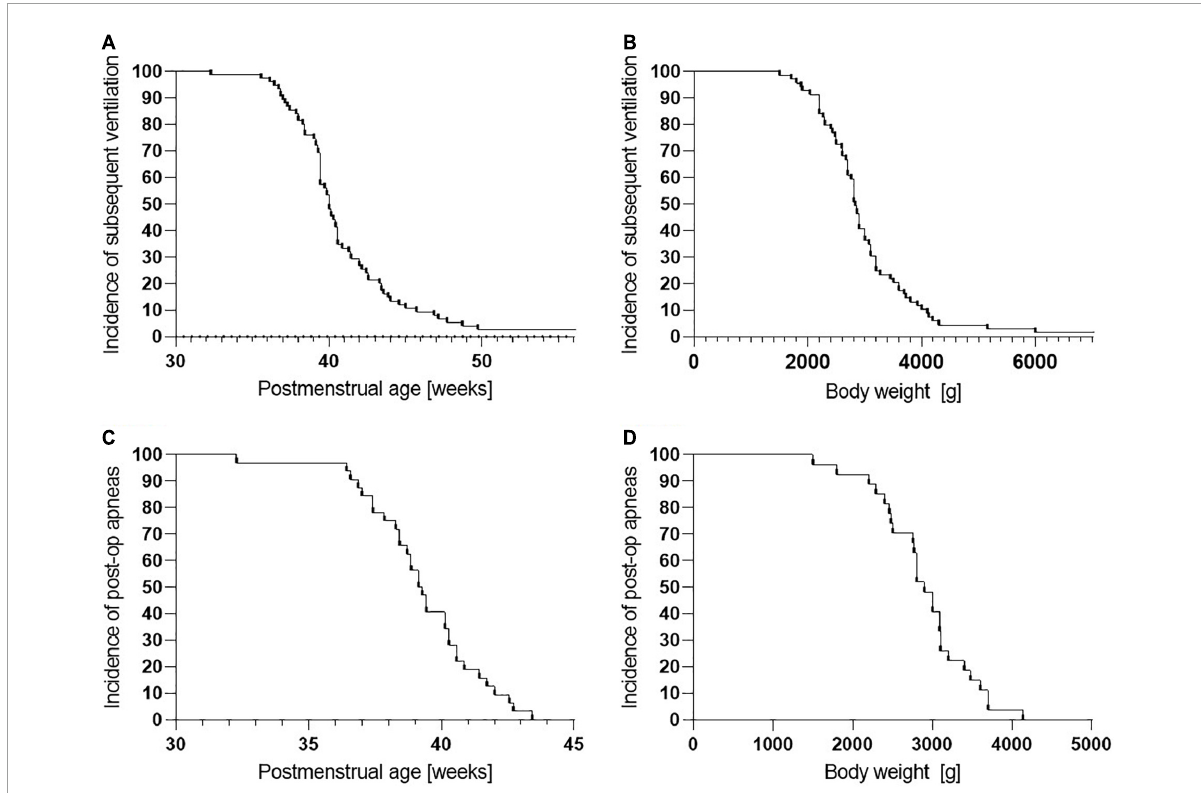
FIGURE2 Cumulative frequency of subsequent ventilation and postoperative apneas depending on gestational age and body weight at time of surgery. (A) Subsequent ventilation depending on postmenstrual age (PMA) at time of surgery. Less than 10% of delayed extubations occurred after 45 weeks of PMA. (B) Subsequent ventilation depending on body weight at time of surgery. Less than 10% of delayed extubations occurred with a body weight of more than 4,100 g. (C) Post-op apneas depending on PMA at time of surgery. Less than 10% of post-op apneas occurred after 42 weeks of PMA. No post-op apneas occurred after 44 weeks of PMA. (D) Post-op apneas depending on body weight at time of surgery. Less than 10% of post-op apneas occurred with a body weight of more than 3,600 g. No post-op apneas occurred beyond 4,100 g.